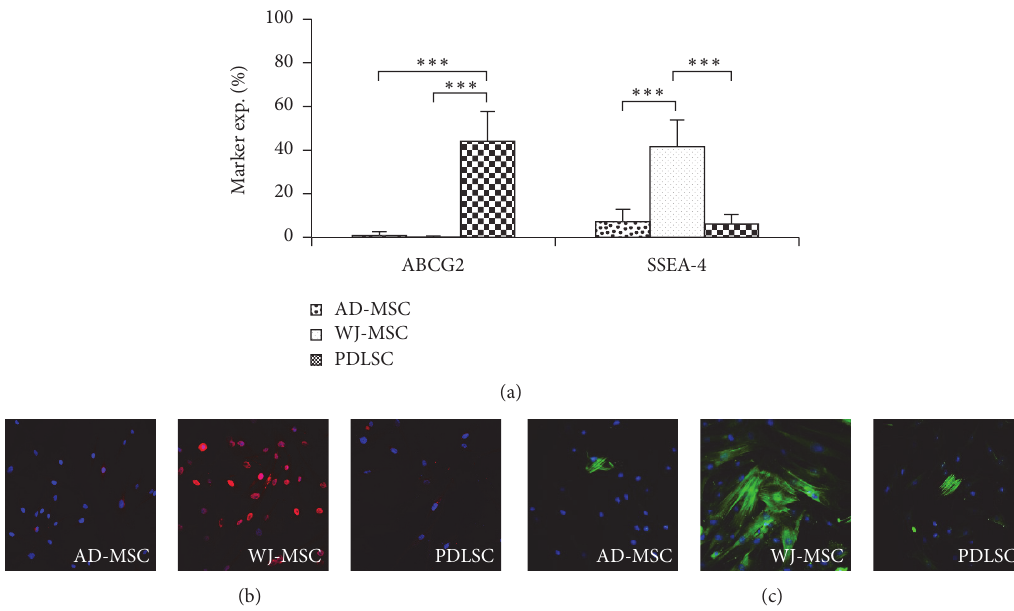
Figure 5: Pluripotency and mesodermal markers of MSCs. The embryonic stem cell marker ABCG2 was detectable uniquely in PDLSCs, while a remarkable SSEA4 expressing population was found in WJ-MSC isolates, as determined by flow cytometer (a). Immunohistochemical staining of GATA6 (red, DAPI-blue) (b) and 𝛼 -SMA (green, DAPI-blue) (c) showed significant expression only in WJ-MSCs. The photos demonstrate representative samples. ∗∗∗ 𝑃 value less than